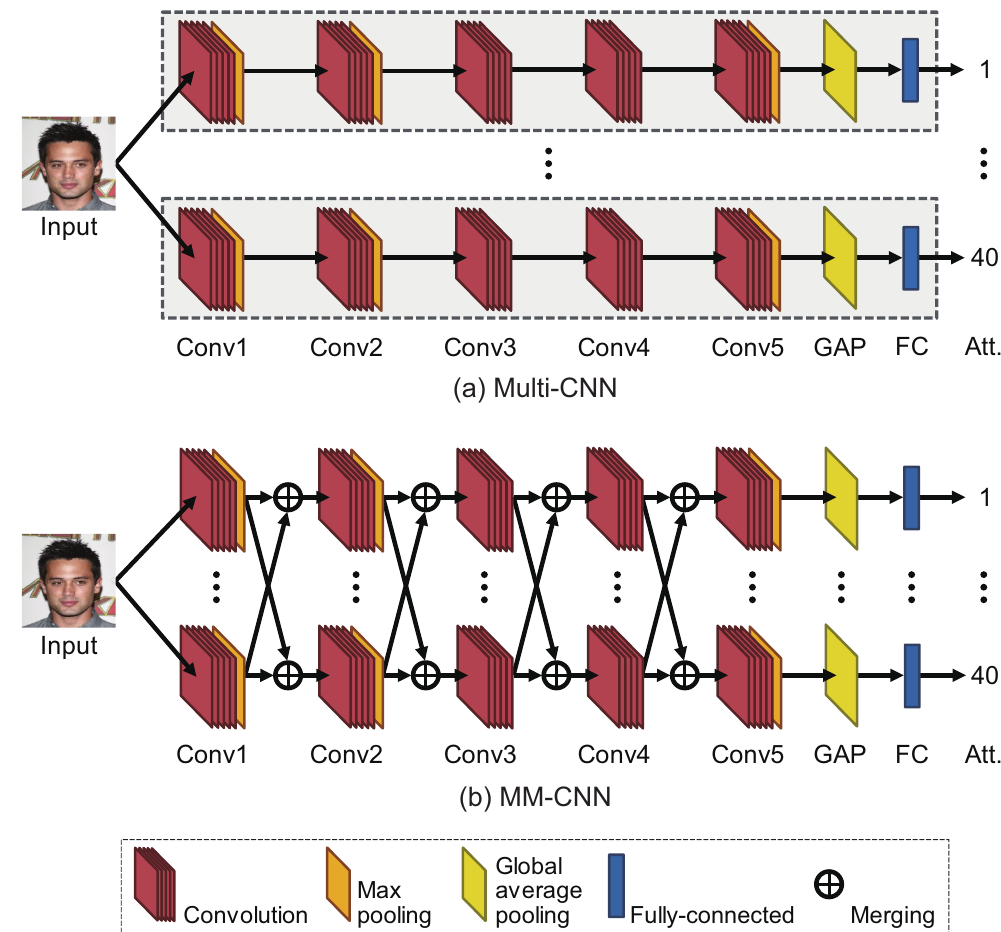
Figure 4. Overview of network architectures for ( a ) Multi-CNN and ( b )